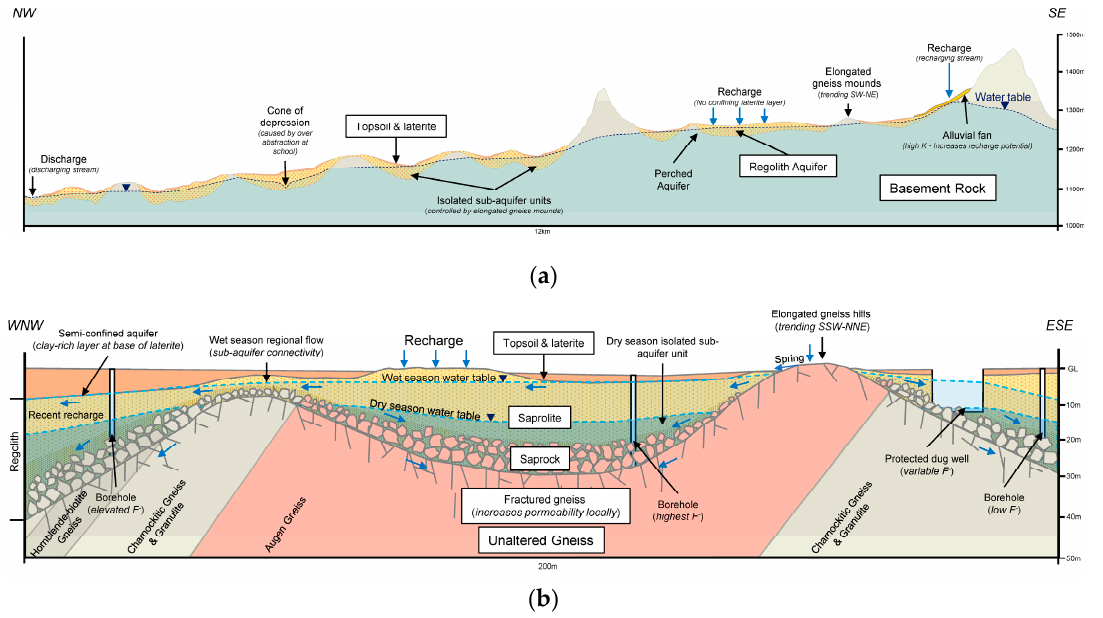
Figure 3. ( a )—Aquifer cross-section (A–B) of study area showing decreasing altitude and groundwater levels southeast-northwest from recharge at high elevation to discharge at low elevation (vertically exaggerated), topography surface, aquifer depth and water table levels calculated from data. The figure shows semi-isolated nature of regolith aquifer units. ( b )—Schematic hydrogeological conceptual model (not to